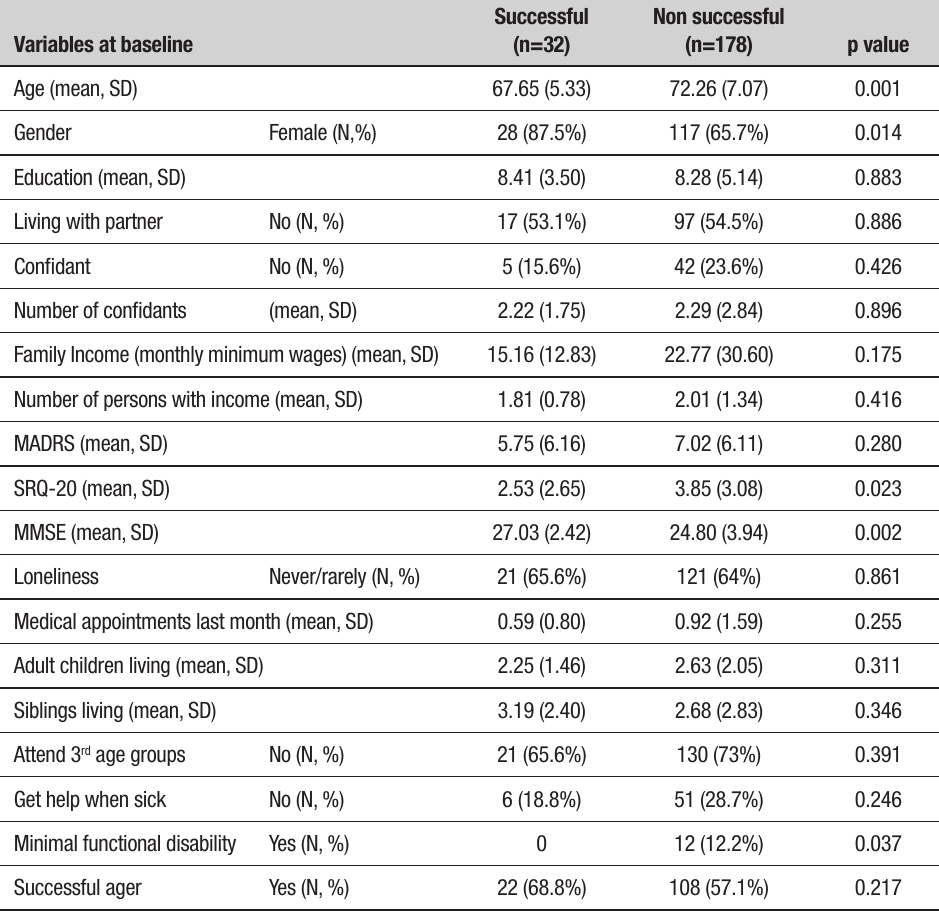
Table 1. Comparison of baseline characteristics between successful and non-successful aging groups. Variables at